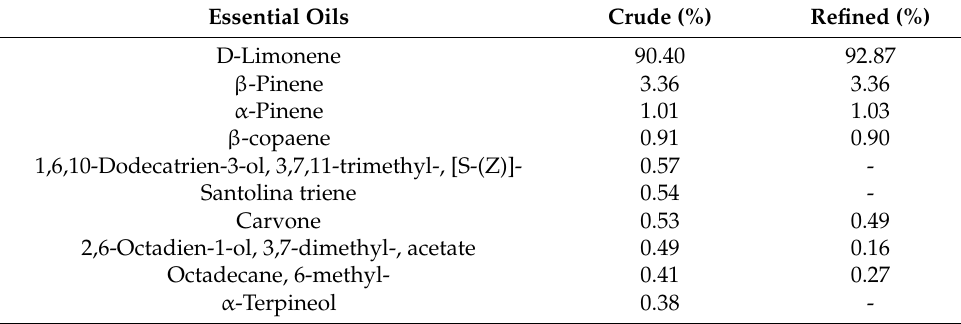
Table 3. Ingredients of crude and refined calamondin peel oil [12].